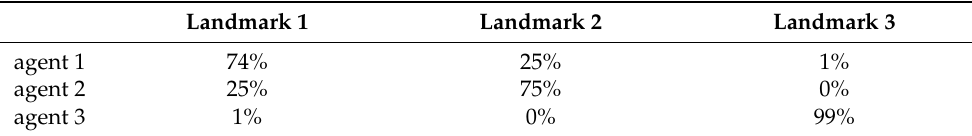
Table 1. Percentage of episodes where a given agent covered a given landmark with the vanilla MADDPG algorithm. Only those episodes where all three landmarks were covered by exactly one agent (48% of all episodes) were counted. Agent and landmark numbers refer to their positions in observation.